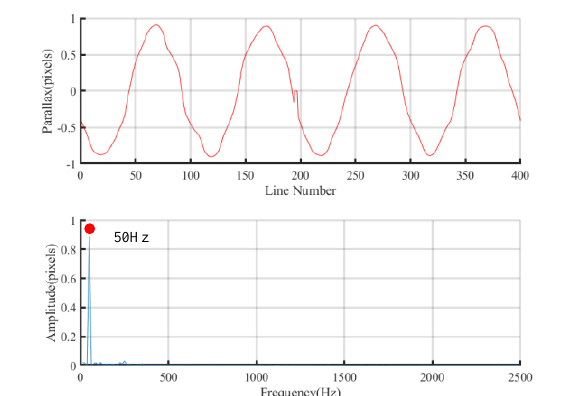
Figure 3. Multi-temporal images which affected by a modelled Figure 4. Parallax curve with simulated jitter frequency of 50 jitter. Hz, matching window size is 128(cross)* 16